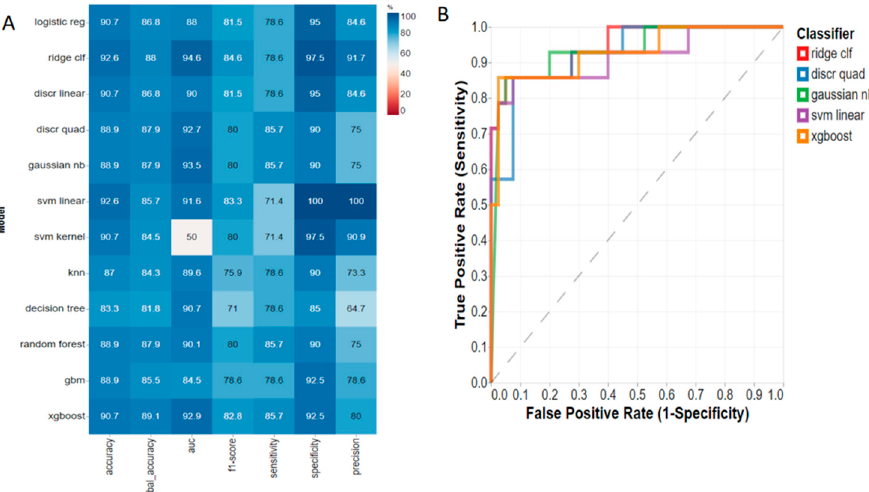
Figure 2. ( A ) Serum metabolite predictive models and ( B ) receiver-operating characteristic (ROC) plots for three-month post-sleeve gastrectomy weight loss outcomes: highest %TWL tertile (T3) versus all patients at baseline. Note: %TWL = percent total weight loss; logistic reg = logistic regression; ridge clf = ridge classifier; discr linear = linear discrimination; discr quad = discrete quad; gaussian nb = Gaussian Naive Bayes; svm linear = support vector machine linear; svm kernel = support vector machine kernel; knn = K-nearest neighbors; gbm = generalized boosted regression modeling; xgboost = extreme gradient boosting.